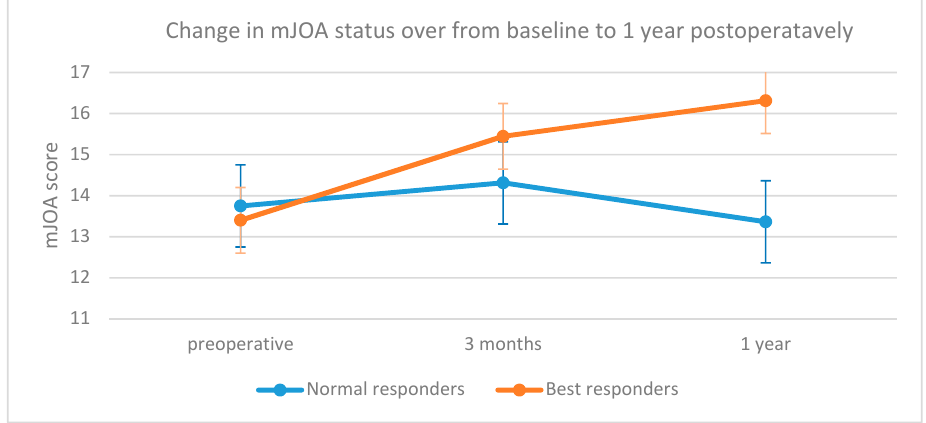
Figure 2. Difference of trends of the average modified Japanese Orthopedic Association (mJOA) scores in the “best responders” and “normal responders” patients. The improvement from the preoperative score to the 1-year value in the “best responders” group was significant ( p = 0.001), as the difference between the 1-year values of the “best responders” (mean = 16.3) and the “normal responders” (mean = 13.3) patients ( p = 0.001).